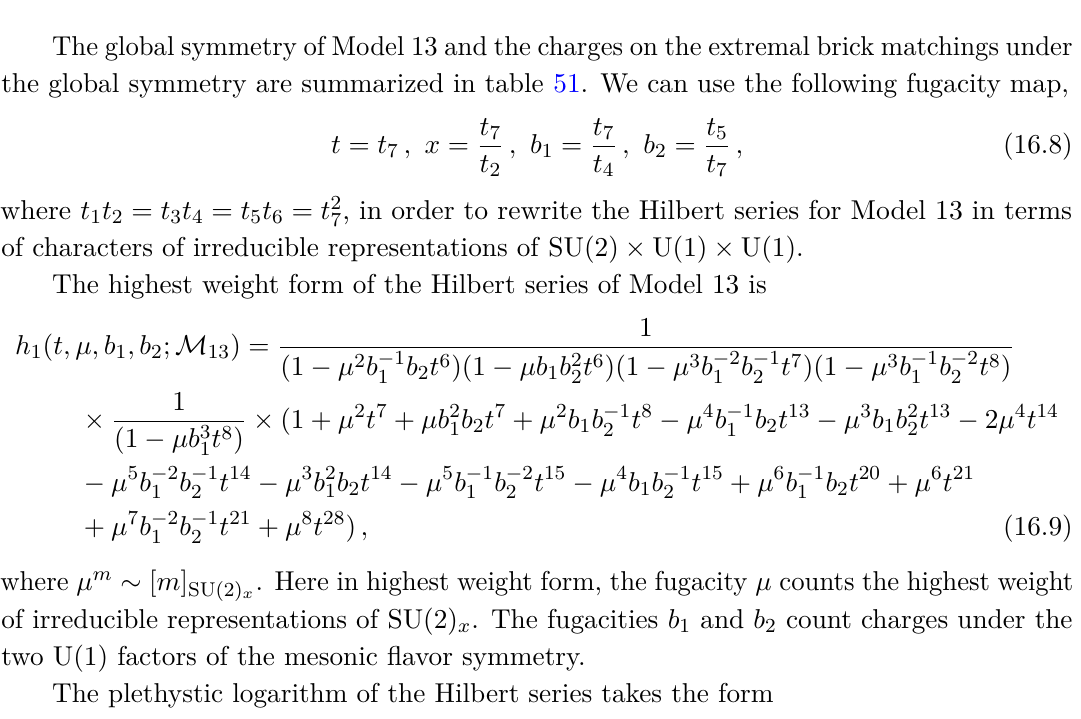
Table 51 . Global symmetry charges on the extremal brick matchings p i of Model